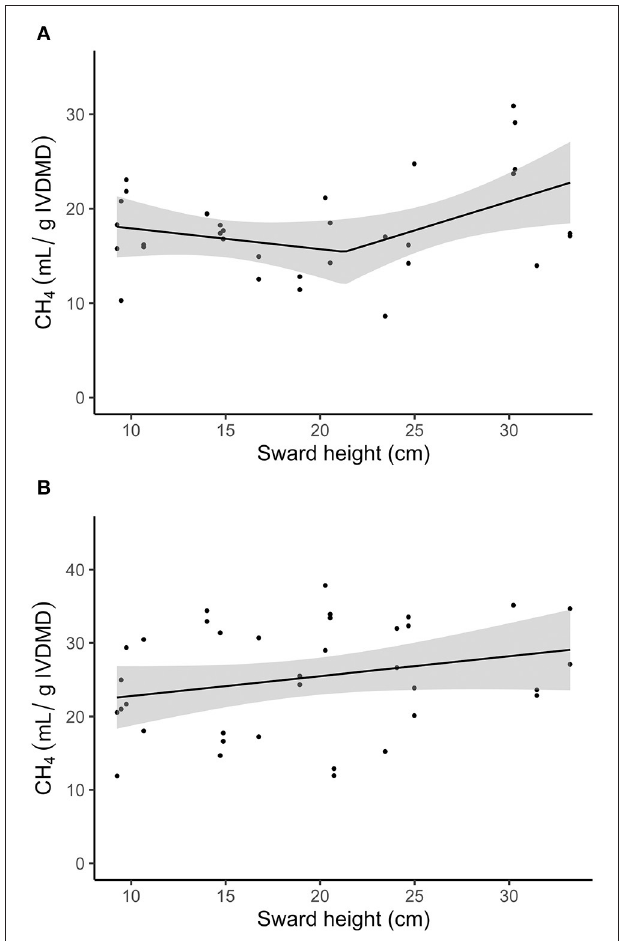
FIGURE 3 | Relationship between in vitro CH 4 (mL/g IVDM) and sward height (SH, cm) of kikuyu grass. Equation for: CH 4 = min [15.4–0.22 (SH −